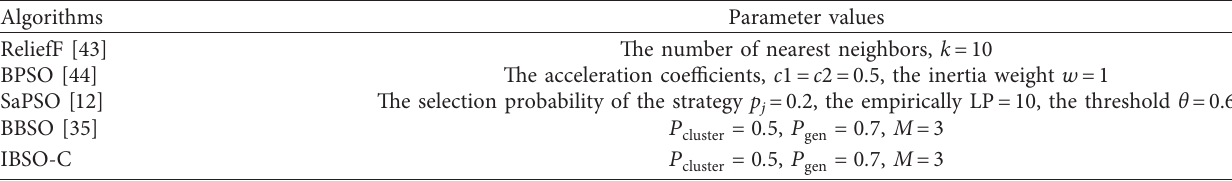
Table 2: Parameter settings.